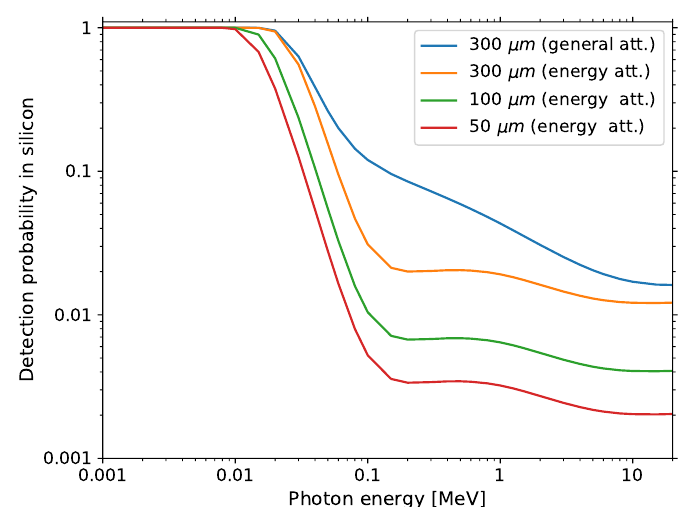
Figure 1. Detection probabilities for photons in 50µm, 100µm, and 300µm thick silicon: The top blue line is derived from the general attenuation coefficient µ . The three curves below are based on the energy attenuation coefficient µ en , which results in even lower probabilities. It takes into account that only a fraction of the photon scattering results in ionisation of sensor material and is able to form a detectable electrical signal. The coefficients are extracted from the NIST database